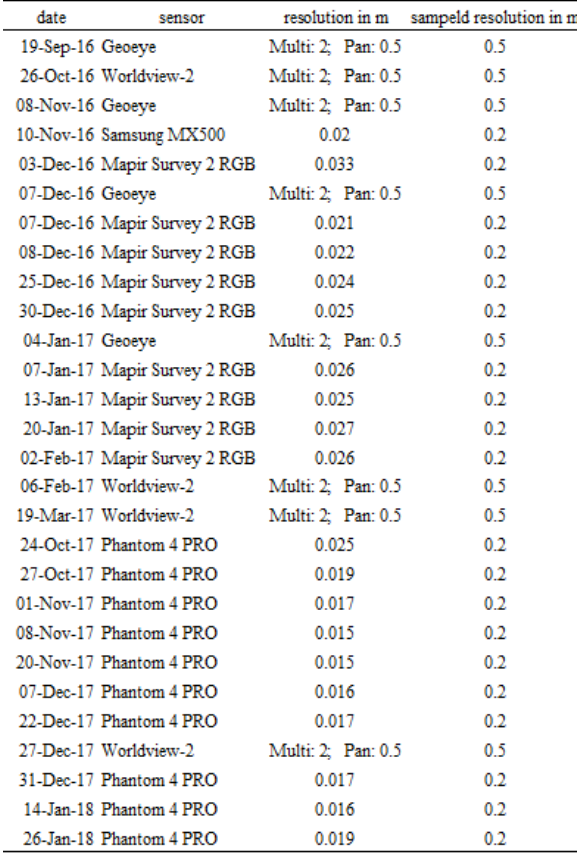
Table 1. Acquired remote sensing data between 2016 and 2018: Multi: multispectral, Pan: panchromatic data types.